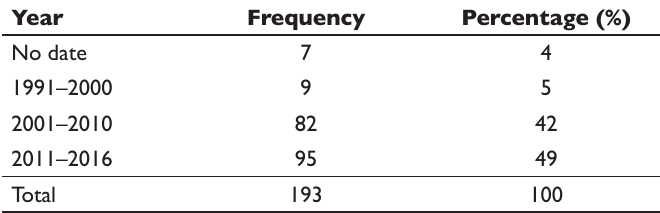
Table 5: Distribution of the literature by year of